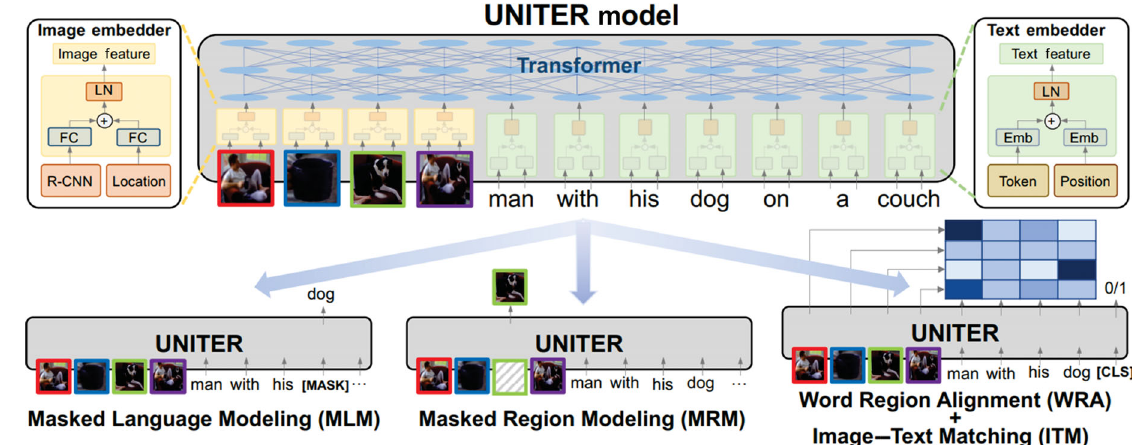
Fig. 24 Overview of UNITER. Reproduced with permission from Ref. [41], c (cid:2) Springer Nature Switzerland AG 2020.